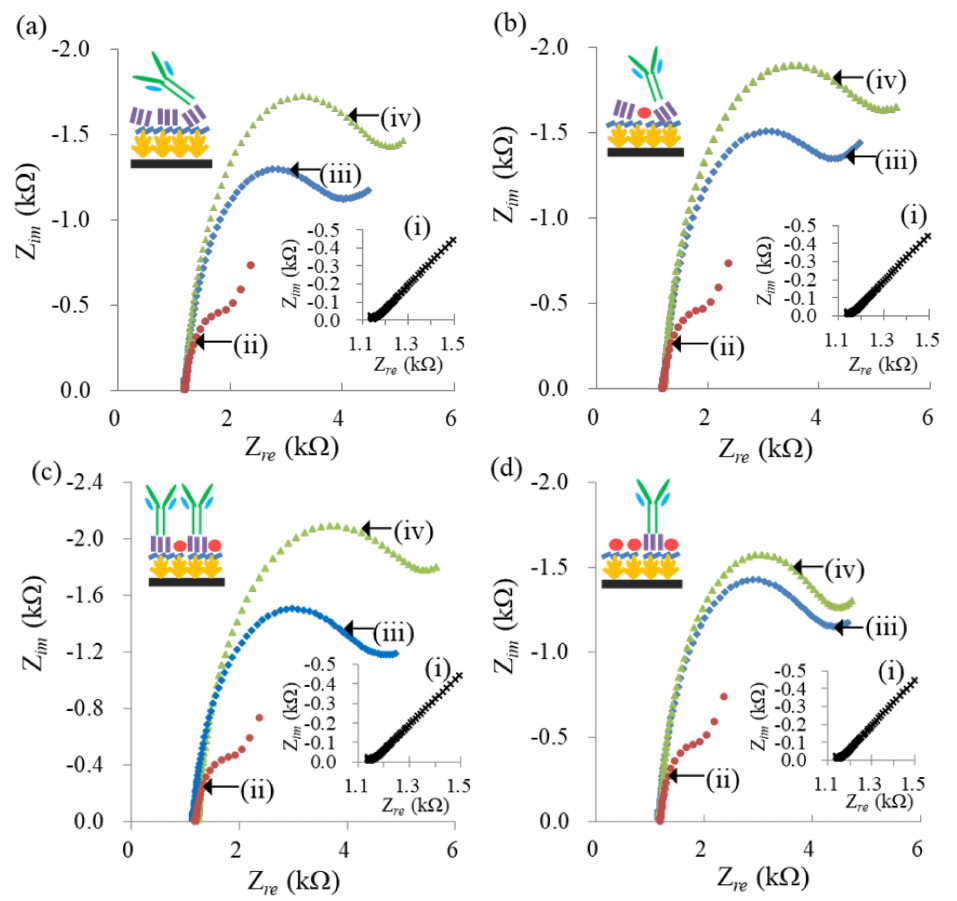
Figure 2. Nyquist plots obtained at the AuNS / SPCEs (i) followed by MPA modification (ii), PA:BSA immobilization (iii) and anti-SAL a ffi nity attachment (iv) in a 10 mM PBS solution containing 100 mM KCl and 2.5 mM equimolar Fe(CN) 6 3 − / 4 − . ( a – d ) respectively represent the electrodes immobilized by the PA:BSA mixture ( µ g / mL) of 100:0, 100:50, 100:100 and 100:200. The inserted schemes depict the possible arrangement and orientation of the